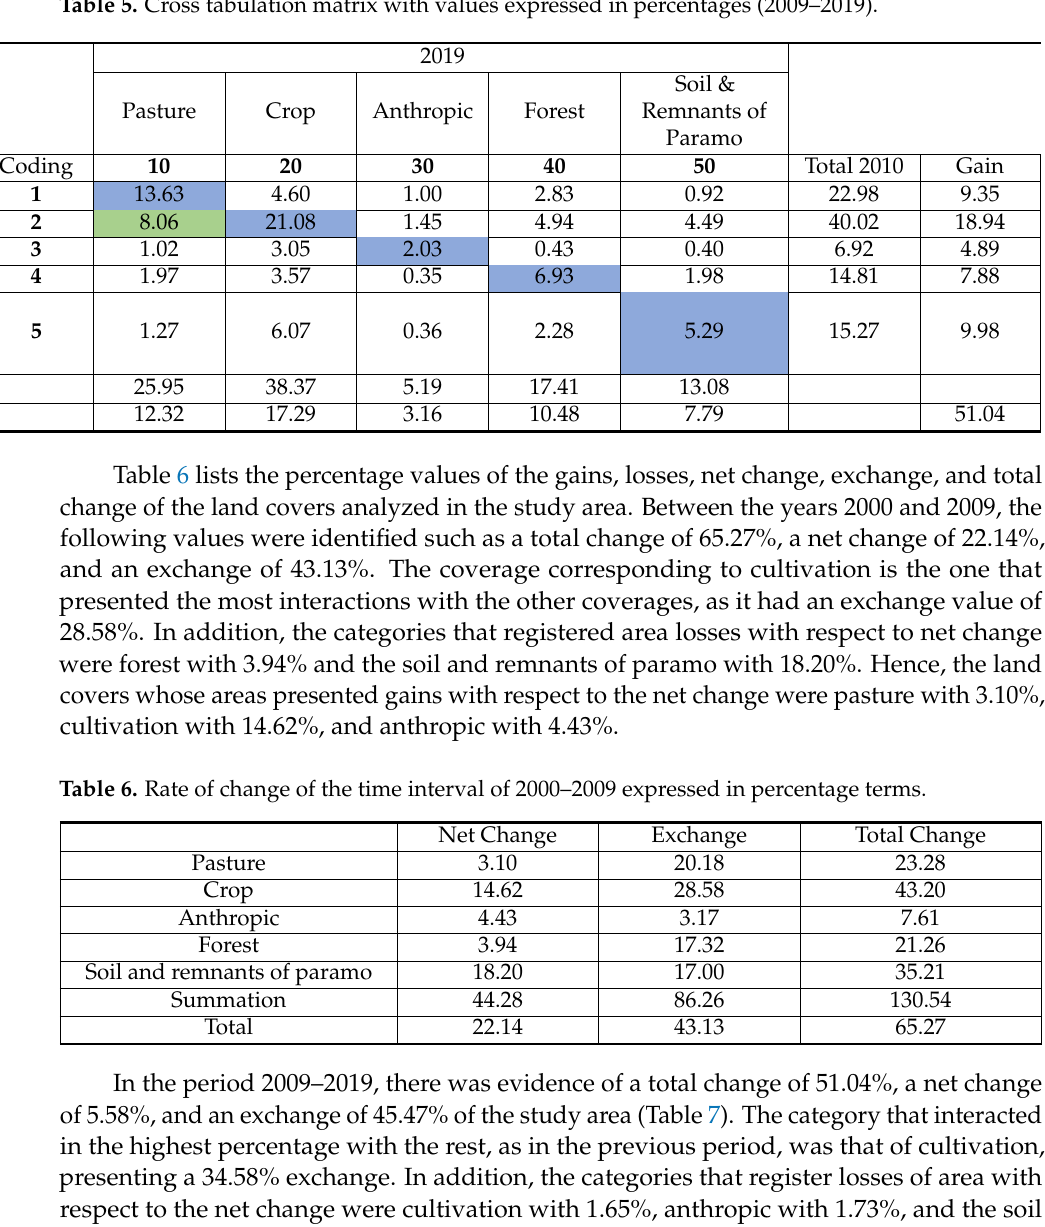
Table 5. Cross tabulation matrix with values expressed in percentages (2009–2019).